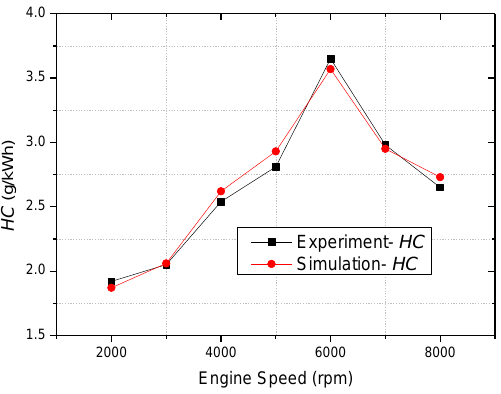
Figure 10. HC emission following engine speed.